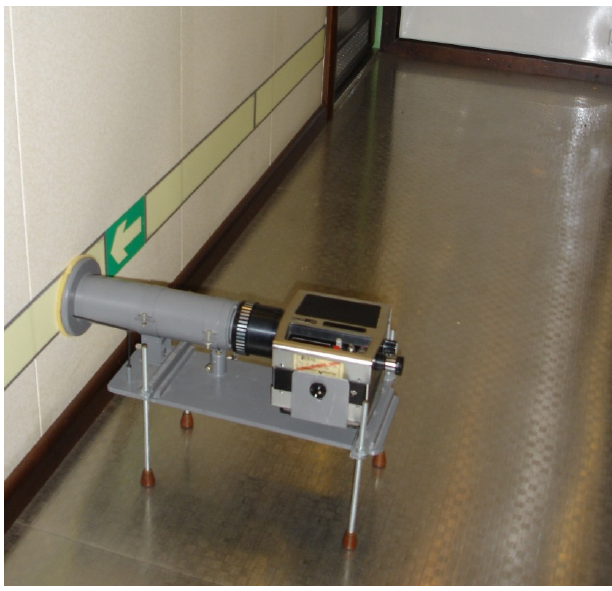
Figure 2. LLL system luminance measurement in real-life operating conditions.